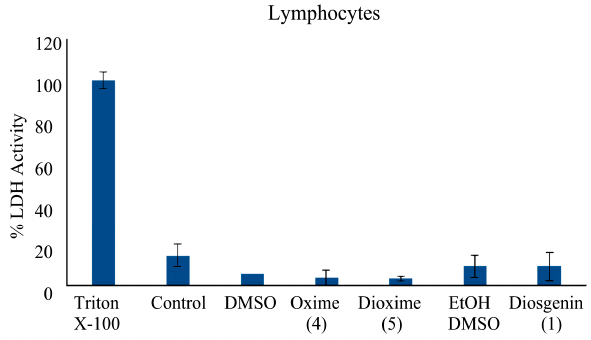
Figure 8. Evaluation of cytotoxicity for compounds 1 , 4, and 5 on human lymphocyte cell cultures.